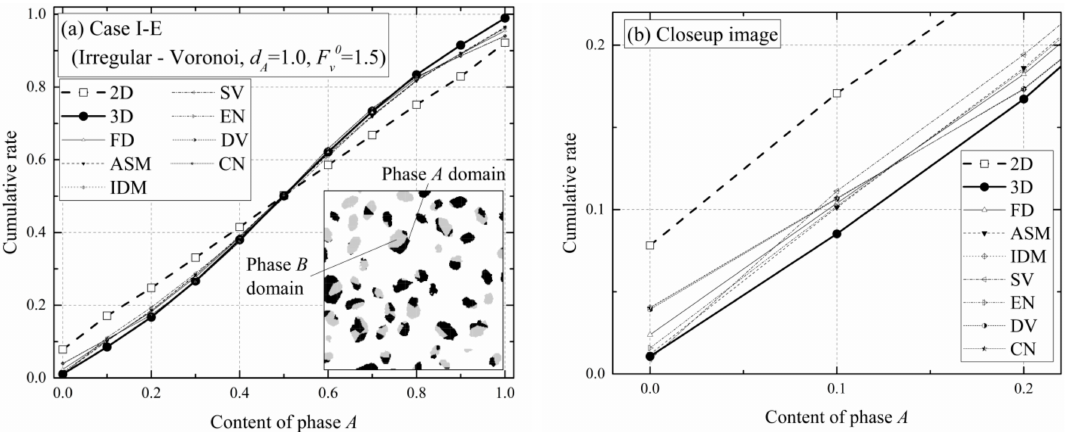
Figure 8. ( a ) Comparison of the 2D composition distribution, true 3D composition distribution, and seven types of 3D composition distribution estimated using seven types of texture analysis indices (FD, ASM, IDM, SV, EN, DV, and CN), for Case I-E (irregularly-shaped particles with Voronoi internal structure, with d A = 1.0, F 0 v = 1.5), along with the corresponding partial sectional image; ( b ) Partial close-up of the chart in ( a ). FD—fractal dimension; ASM—angular second moment; IDM—inverse